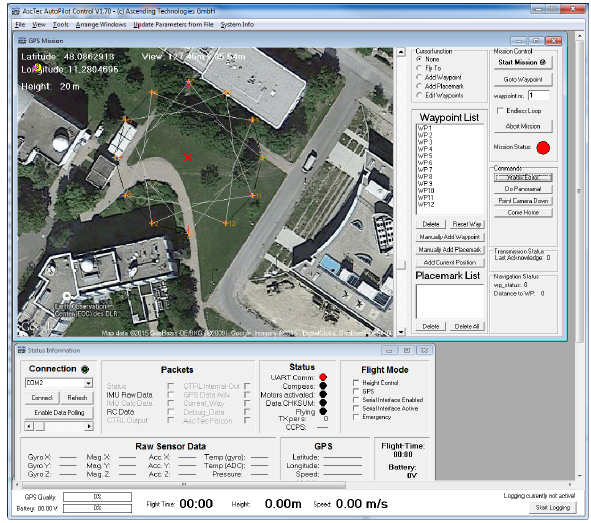
Figure 5: The AscTec Autopilot Control